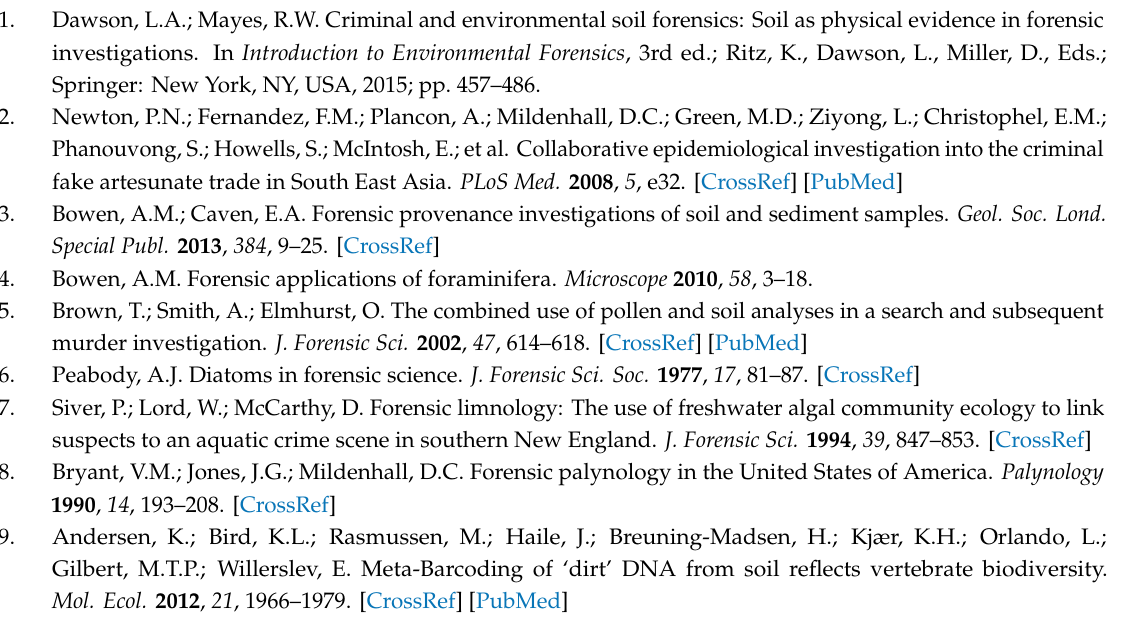
Table S1: Results summary of the wet lab DNA metabarcode protocol for DNA isolated from individual insect and plant fragments collected at 10 sites within Virginia, USA. Table S2: Results summary of the wet lab DNA metabarcode protocol for DNA isolated from bulk soil (either ~250 or ~100 mg) collected at 10 sites within Virginia, USA. Table S3: Average ( ± standard deviation) BLASTN match statistics for the best match of each unique target sequence ( n = 1293). Table S4: Comparison of plant taxa identified from each sample site when using DNA barcoding (i.e., Sanger) and DNA metabarcoding (i.e., MPS). Table S5: Comparison of animal taxa identified from each sample site when using DNA barcoding (i.e., Sanger) and DNA metabarcoding (i.e., MPS). Table S6: Abundance (i.e., number of reads) of unique target sequences which met the BASTA inclusion criteria ( n = 572) across 10 phyla, for samples prepared in duplicate using 250 and 100 mg of bulk soil. Table S7: Number of unique target sequences which met the BASTA inclusion criteria ( n = 572) across 10 phyla, for samples prepared in duplicate using 250 and 100 mg of bulk soil. Figure S1: Map of Virginia, USA showing the 10 sample sites from which surface soils were collected (C–H, J–M), and the land cover categorization. Figure S2: Average ( ± standard deviation) number of unique ( n = 2375) and unique target sequences ( n = 1293) recovered from samples prepared with DNA from bulk soil and individual